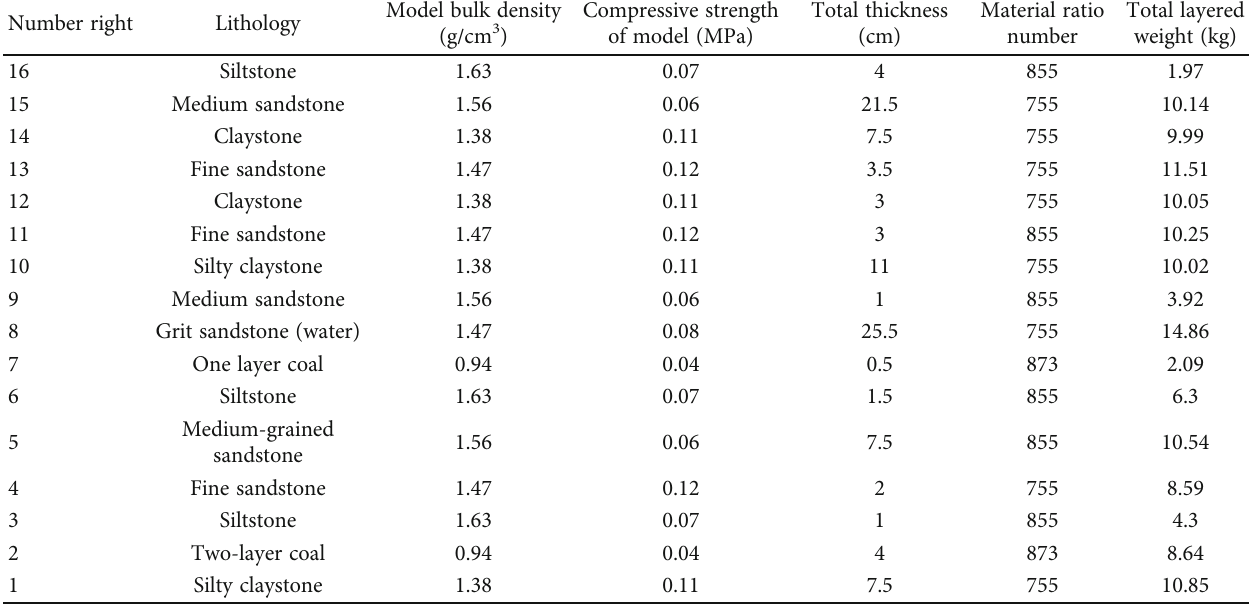
Table 2: Material ratio table of similar simulation test of Y.C.W mine 130204 working face. Number